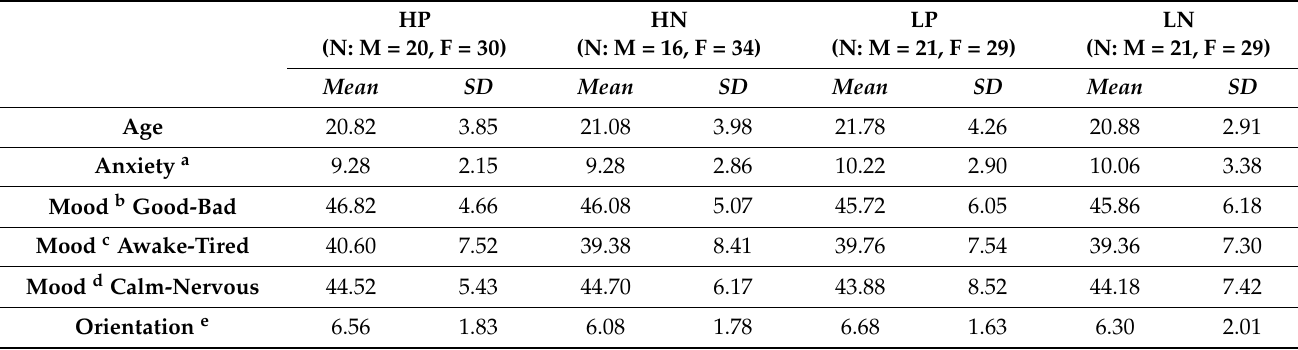
Table 1. The table shows means and standard deviations (SD) for age, anxiety levels, mood, and perceived orientation ability for each experimental condition (i.e., HP, HN, LP, LN). N = number of participants; M = males; F = females.